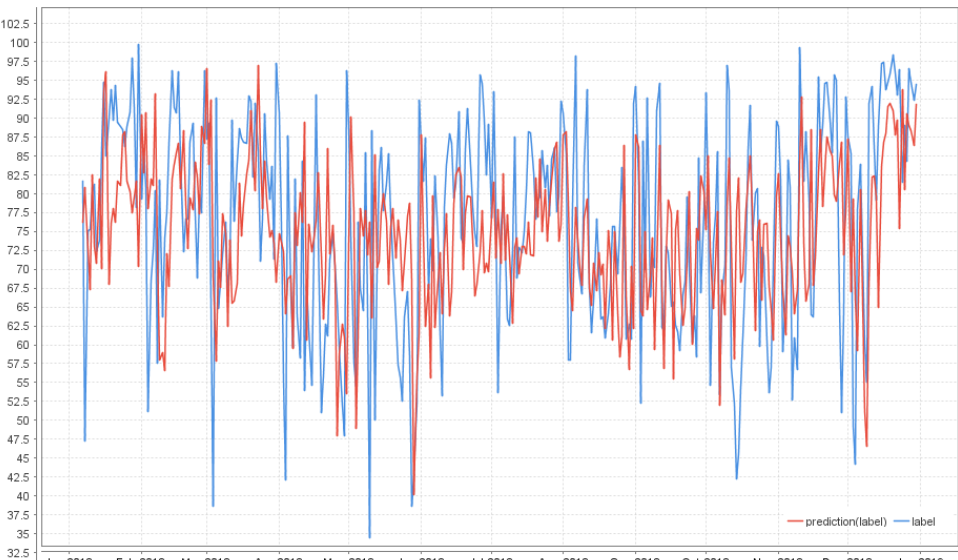
Figure 8. Deep Learning (DL) prediction overview for Sarmasu: CADM + CDM 3 sources scenario: the values for the actual value, in blue, and predicted value, in red ( X -axis) and the time series for which the results were registered ( Y -axis).